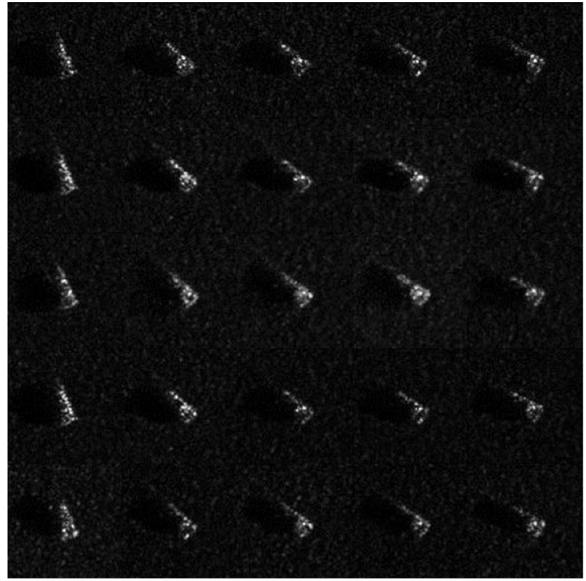
Figure 9. BMP2 partial azimuth reconstruction results.